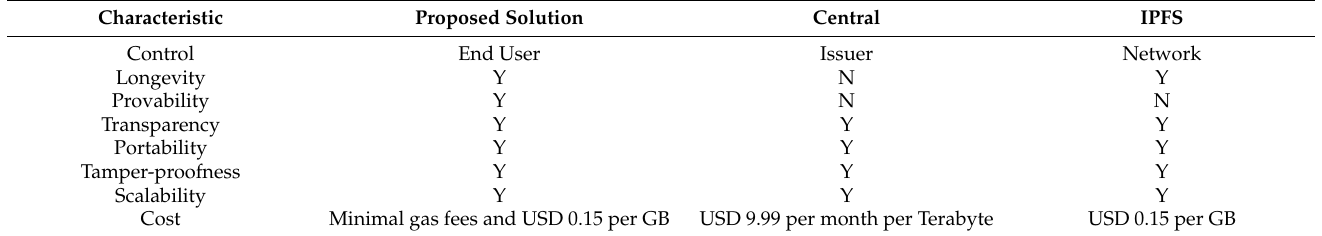
Table 3. Data storage: application comparison between Proposed Solution, Central and IPFS.